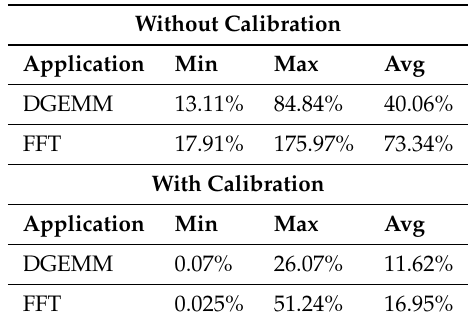
Table A5. Percentage error of dynamic energy consumption by Nvidia P100 PCIe GPU with and without calibration and HCLWattsUp on